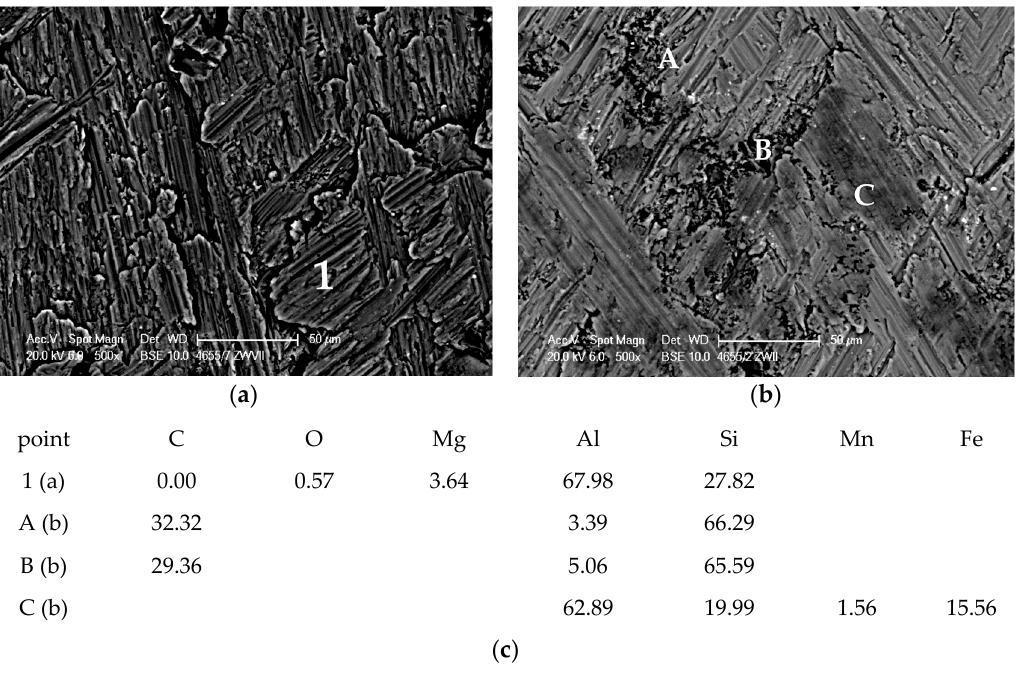
Figure 16. SEM image of worn out surface after abrasion test ( a ) AlSi7Mg2Sr0.03 base alloy; ( b ) AlSi7Mg2Sr0.03/SiC p 10 vol % composite; ( c ) EDS analysis of elements at points.